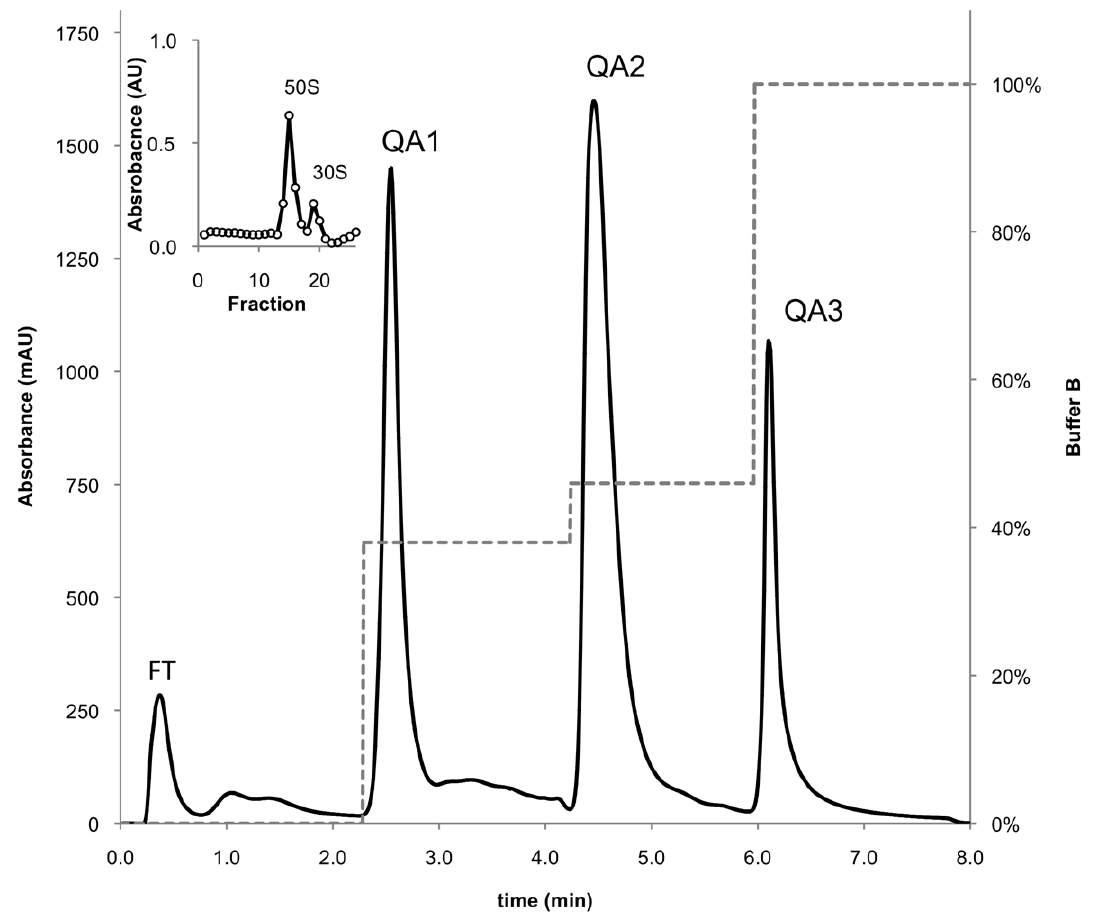
Figure 1. Purification of M.smegmatis ribosomes using monolithic columns. M. smegmatis cell extracts were loaded onto a quaternary amine monolithic column and ribosomes were isolated following a stepwise elution. The absorbance (solid line) and the proportion of Buffer B (dashed line) are shown and the flow-through (FT) as well as fractions QA1-3 are annotated. Fractions from QA2 were analysed by linear sucrose gradient ultracentrifugation and found to contain 30S and 50S ribosomal subunits (inset).